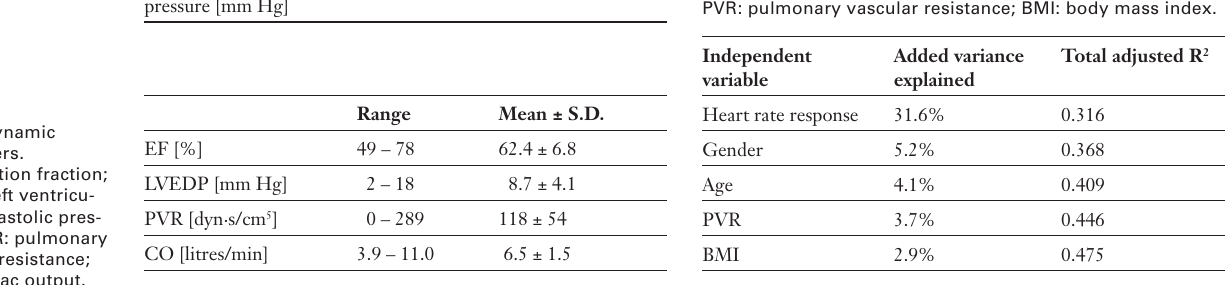
Exercise parameters (values = mean ± S.D.). MET: metabolic equivalent.